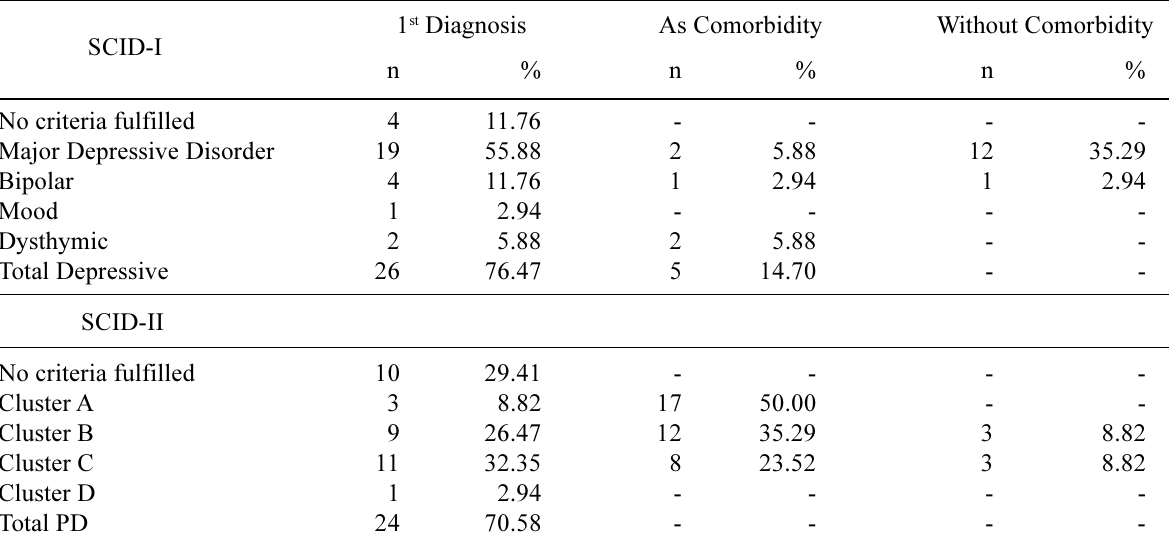
Diagnostics and Symptoms or Behaviors of 34